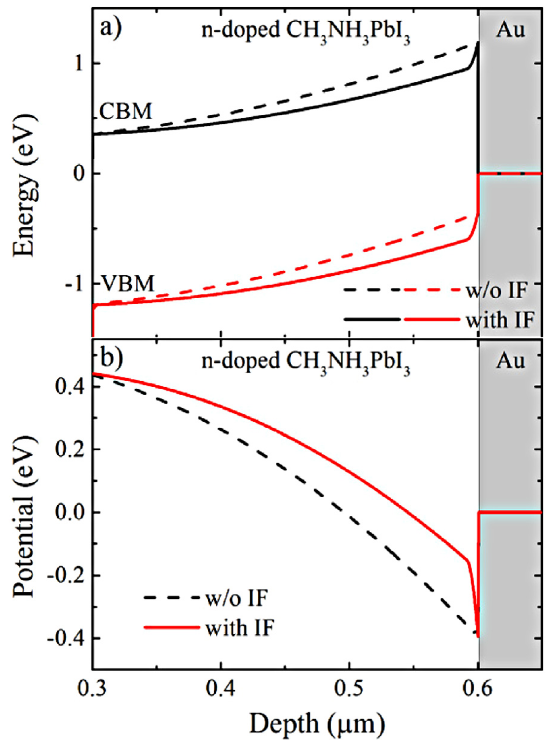
Fig. 6. (a) Static band alignment and (b) potential profile with and without interfacial layer